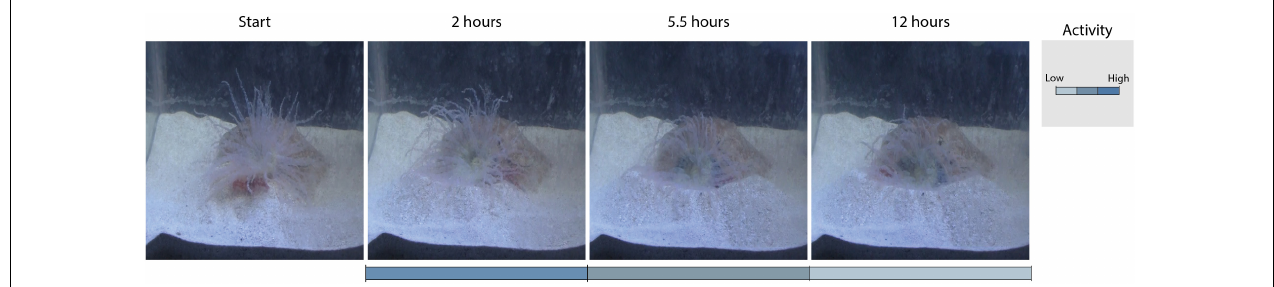
FIGURE 8 | Photographic registers showing the external appearance of anemones B. annulata and their artificial shelters at different moments throughout observation experiments: Start (before shrimp were introduced), after 2, 5.5, and 12 h of den cleaning by Alpheus spp. Shades of blue indicate high, medium and low cleaning activity as the relative frequency of resting increased and sweeping, tamping and dumping increased. Note that differences are only clearly visible within the first 2 h of observation. Thereafter, the external appearance of the entrance remained almost unchanged ( Supplementary Material 4 ).